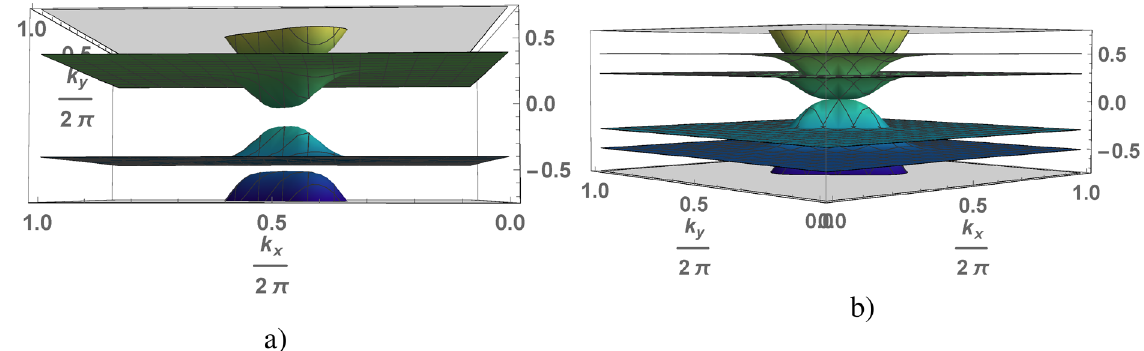
0.2 , (cid:31) 0.2 : (cid:31) 0.1656 at H 0 = = = =